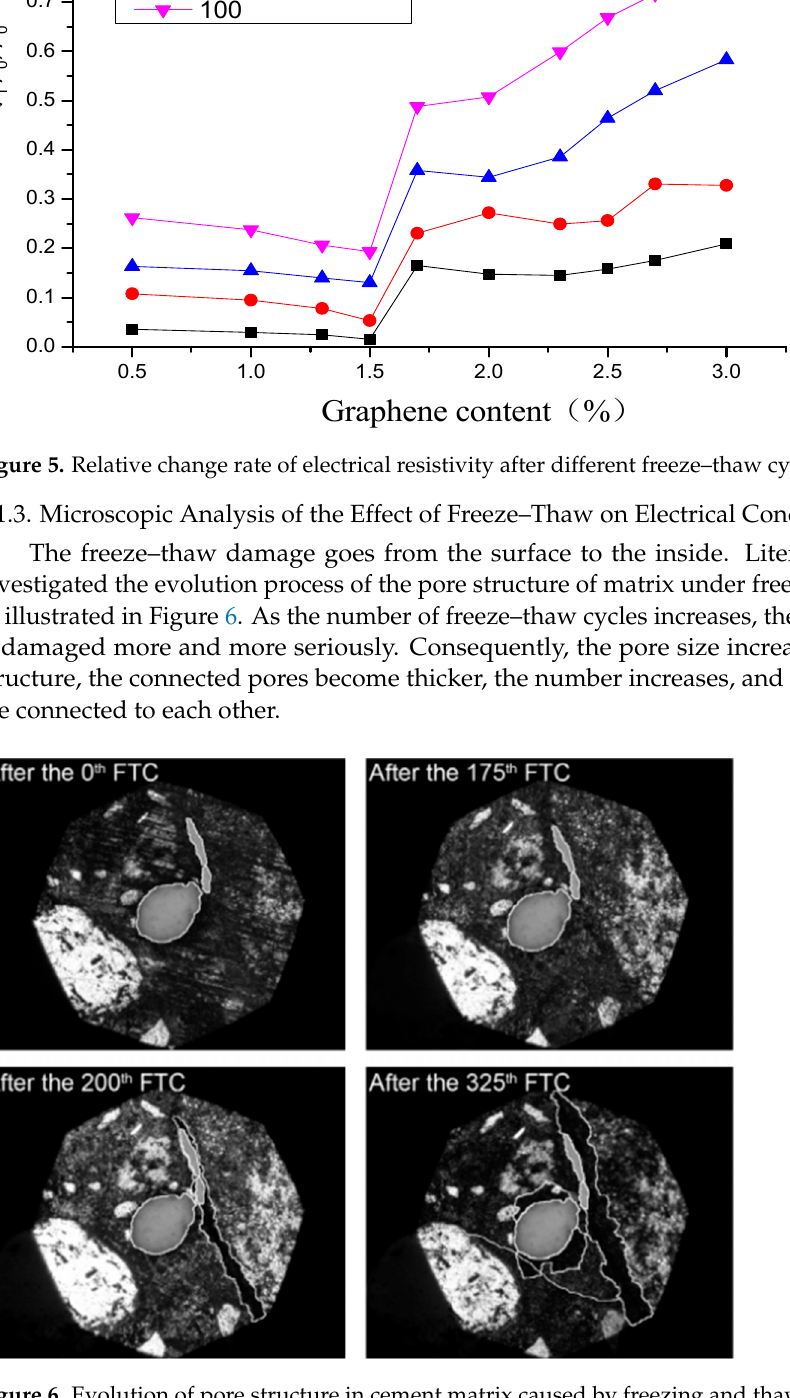
Figure 6. Evolution of pore structure in cement matrix caused by freezing and thawing